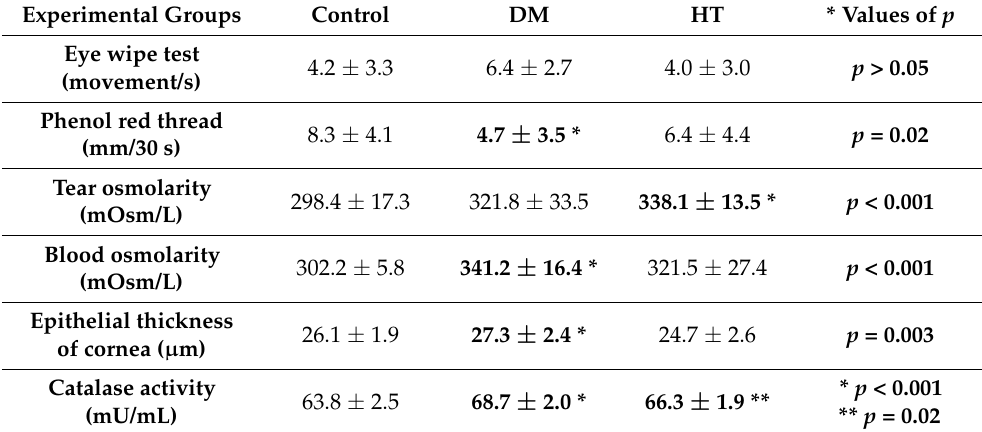
Table 1. Comparative functional and laboratory paired analysis between DM or HT groups and the control group. The comparisons were made between experimental groups and the control group at their final experimental period using the Mann–Whitney U test. In all tests, n = 10/animals per group. Significant values were written in